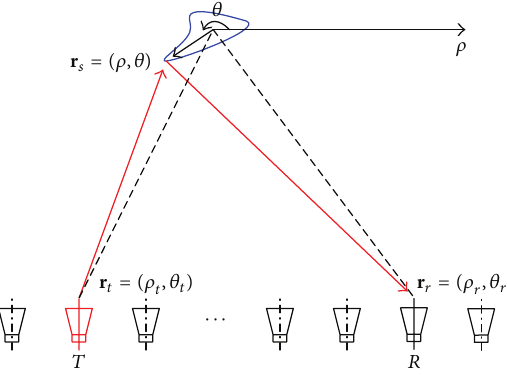
Figure 1: The geometry of the MIMO array imaging